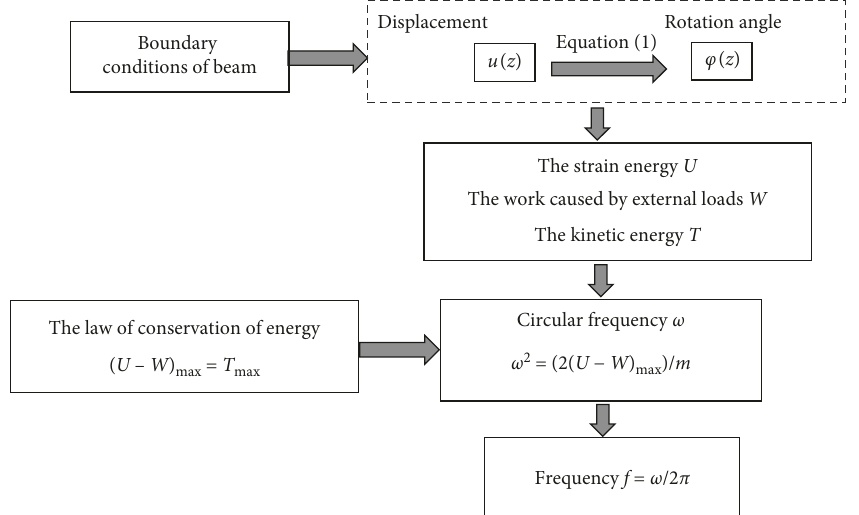
Figure 3: Flowchart to determine the free vibration frequencies by Approach